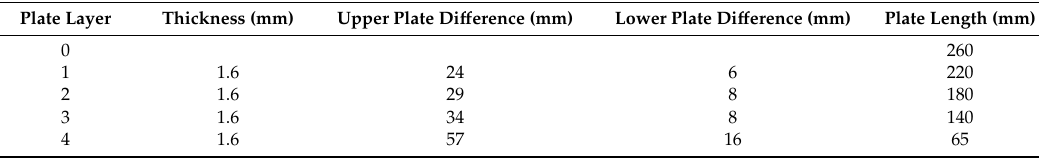
Figure 3. Experimental procedure and sample preparation. 3. Analysis of Measurement Results This section is divided into two parts of the sample and model experiments. For the oil-polymer samples, it mainly includes dielectric characteristics of the combination of uniform and non-uniform moisture. The experiment of the bushing model mainly includes the positioning research when the moisture distribution is non-uniform. 3.1. Oil-polymer Samples 3.1.1. Uniform Moisture The unit laminated oil-polymer samples with different moisture contents were prepared according to the method in Section 2. The FDS test is conducted using a frequency band ranging from 1 mHz to 5 kHz at 40 °C. After the FDS test, the moisture content of the paper was re-calibrated with the Metrohm KFT831 Coulometer. The FDS characteristic curve of the uniformly dampened oil- impregnated polymer sample is shown in Figure 4 and Figure 5. It can be seen from Figure 4 that with the increase of moisture content, the tan δ - f curves show an increasing trend as a whole, and the increase in the middle frequency band is significantly larger. For the oil-polymer samples with moisture content of 0.41%, 1.10%, 2.03%, and 2.84%, the overall curve of tan δ - f is in the shape of “checkmark.” For the samples with moisture content of 3.91%, 5.08%, and 6.11%, the increase in tan δ -